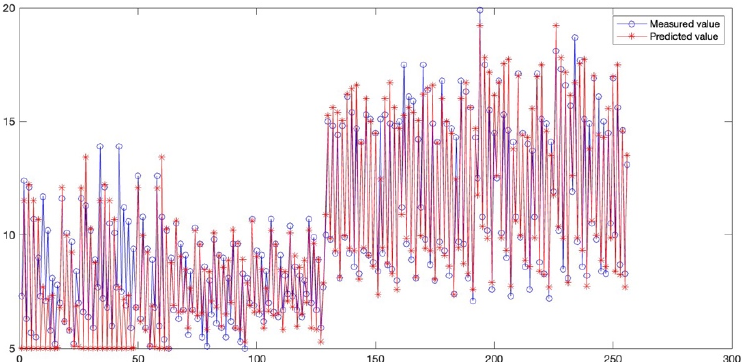
Figure 10. The comparison between the actual value of the bond strength of the plywood and the predicted value of the BP model is shown in Figure 10.